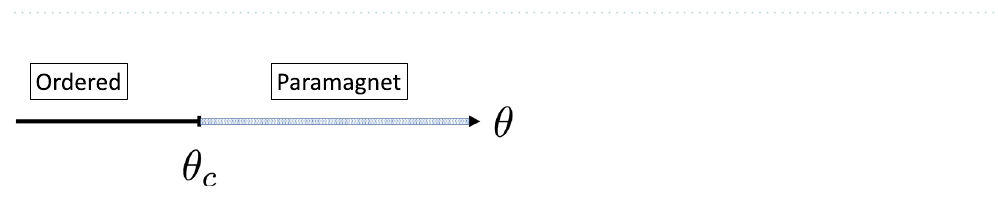
Figure 1. Schematic phase-diagram of the diluted TIM in dimensions d ≥ 2 at T = 0 . In this paper, the shaded region of the Griffiths-phase is considered. In one dimension ( d = 1 ) p c = 1 and h ∗ = 1 .